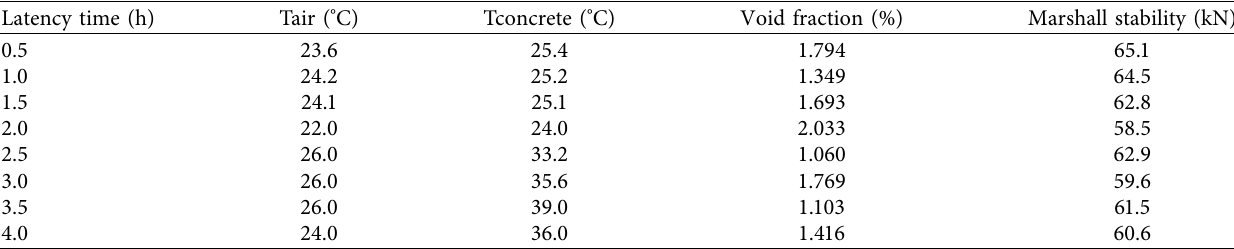
Table 9: Workable performance of CME concrete at room temperature.